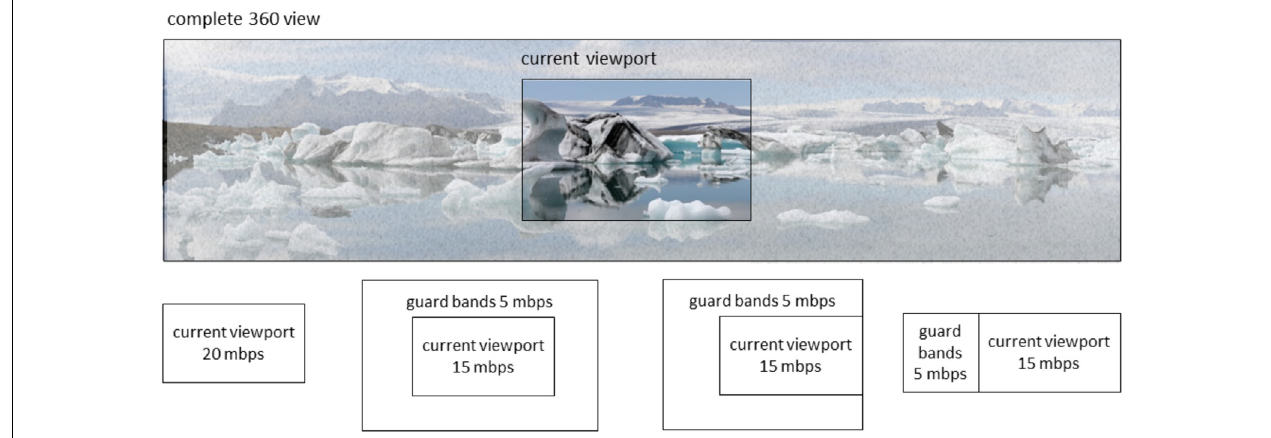
FIGURE 1 | Schematic representation of possible streaming decisions in terms of spatial area and mbps (megabit per second) to present images to a user of a VR headset. The lower insets, respectively, represent possible decisions in cases that the head is not expected to rotate; expected to rotate in an unknown direction; expected to rotate in some leftward direction; and expected to precisely rotate to the